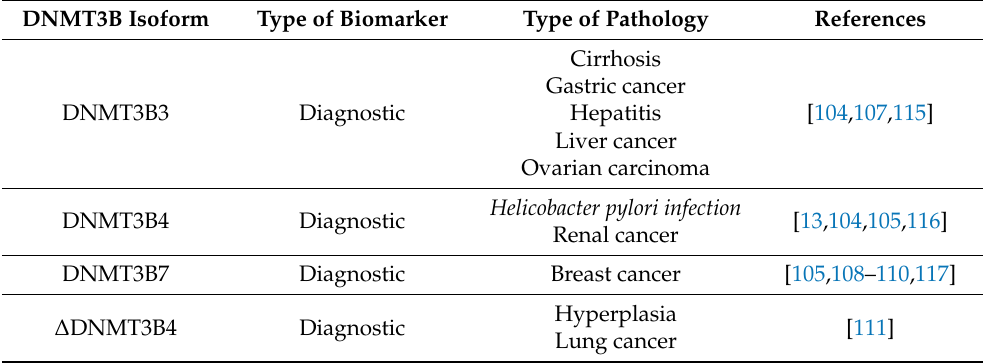
Table 3. Messenger RNA of DNMTs